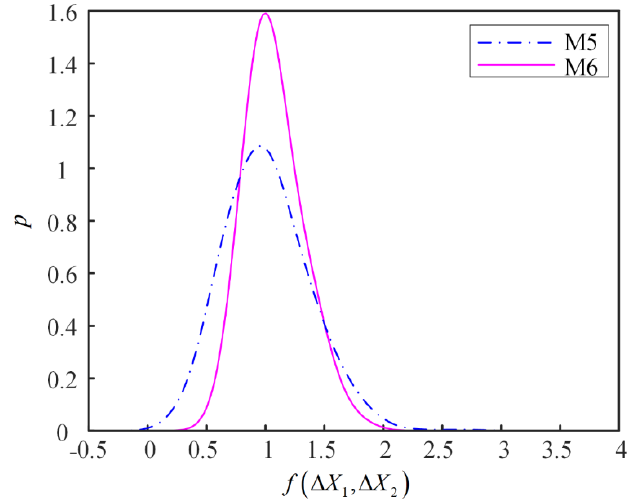
Figure 14. Failure probability distribution functions for three different models. Table 8. Comparisons of the MTTF for different reliability estimation models.